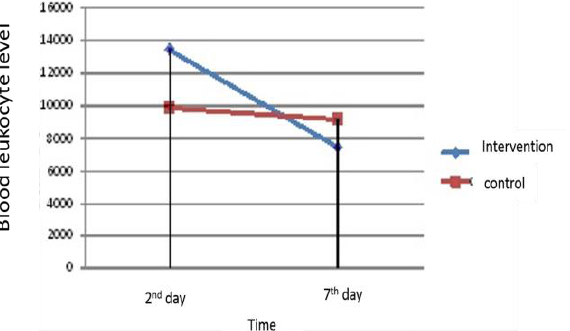
Figure 3. Blood leukocyte level in study